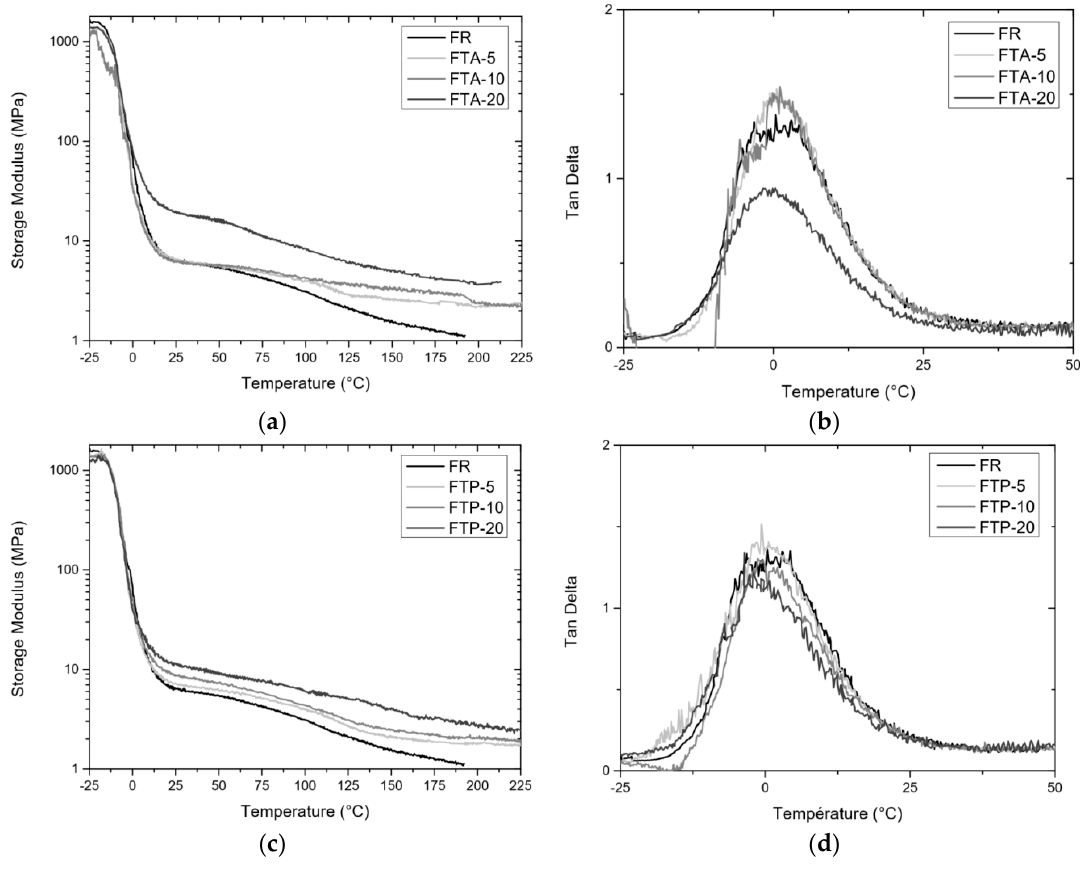
Figure 11. Temperature sweeps of the F T nanocomposites: ( a , b ) F TP , ( c , d ) F TA .